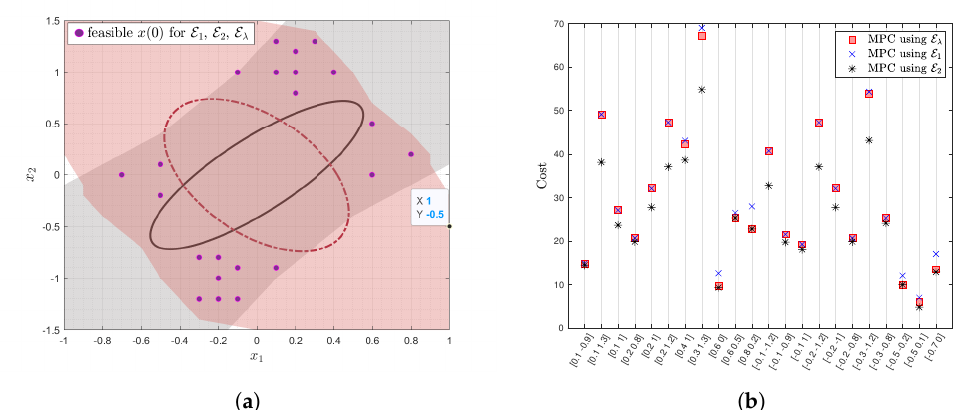
Figure 6. ( a ) Simulation cost ∑ ∞